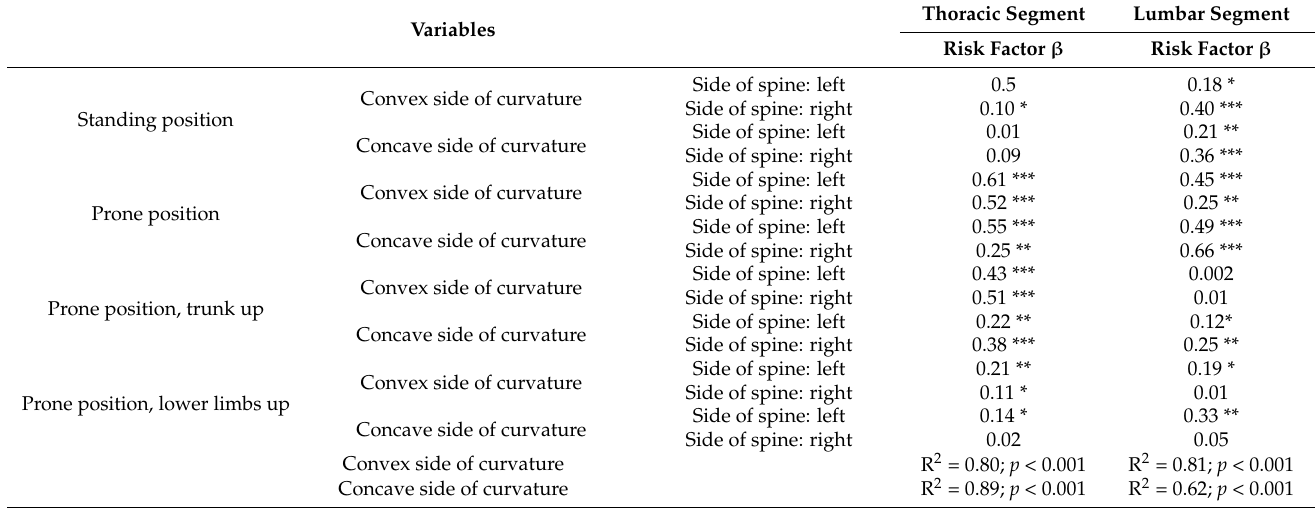
Table 3. Correlation between erector spinae muscle tone (sEMG) and the convex as well as concave sides of spinal